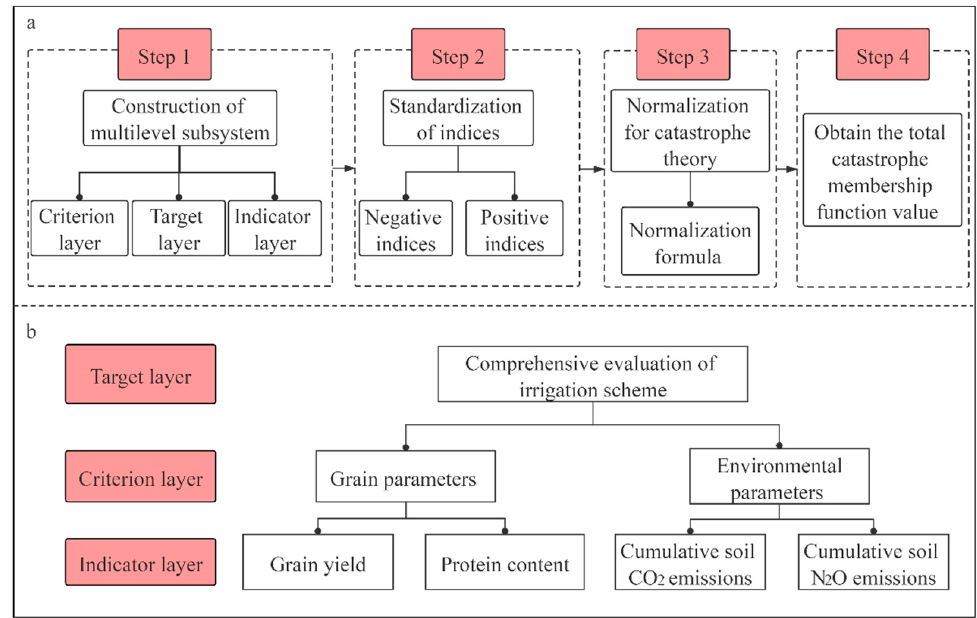
Figure 1. Main steps in the catastrophe progression method ( a ) and evaluation indices of irrigation treatments used in the catastrophe progression method ( b ).